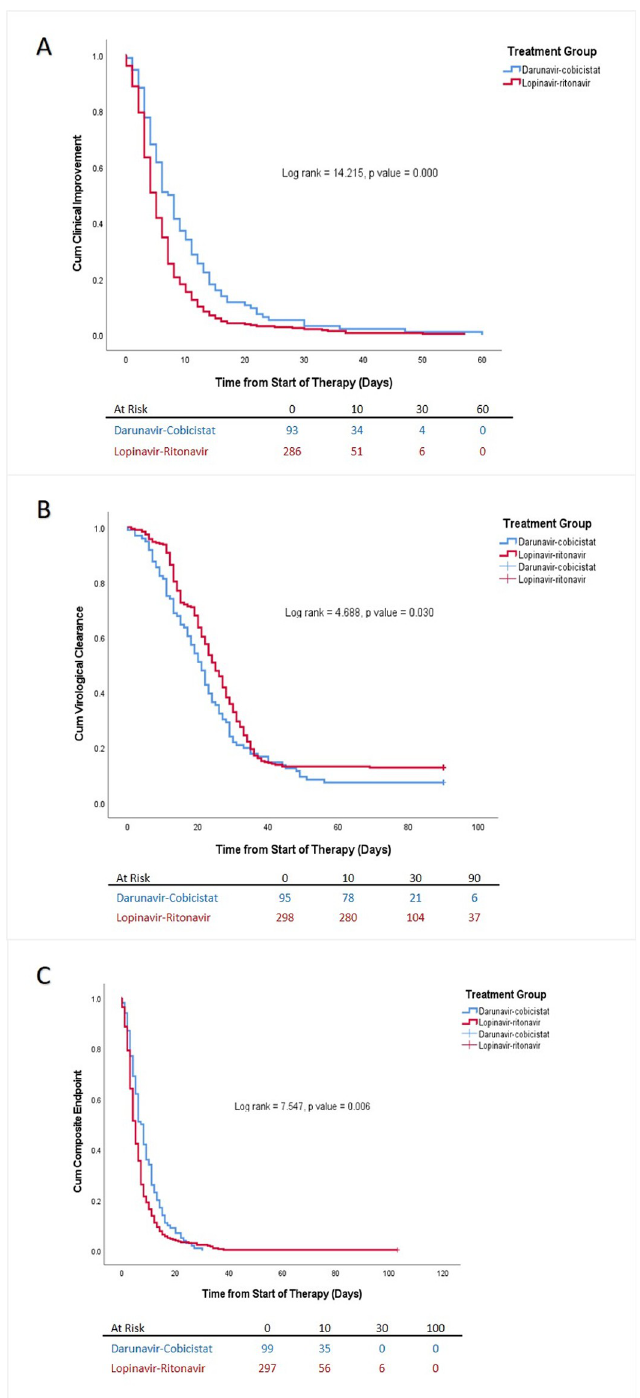
Fig 1. Kaplan-Meier curve for the time to primary outcomes. (A) Time to clinical improvement. (B) Time to viral clearance. (C) Time to first composite of primary outcome.